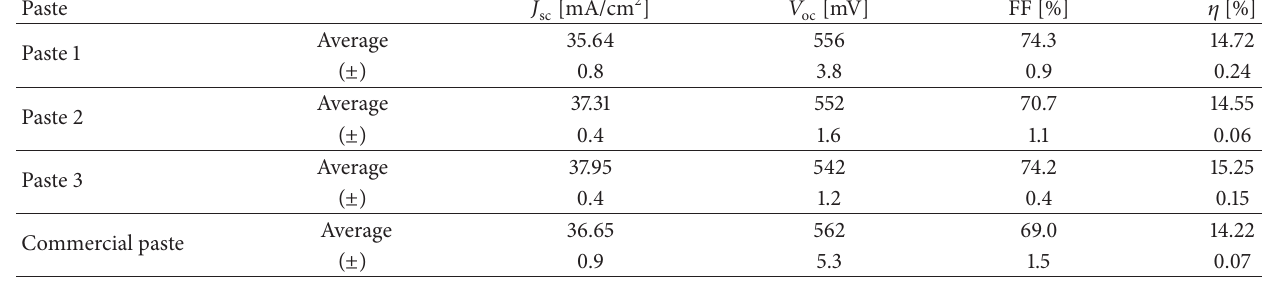
Table 5: Electrical properties of fabricated cells with developed polyvinyl alcohol-based aluminum pastes (average of 3 textured, w/ARC cells).